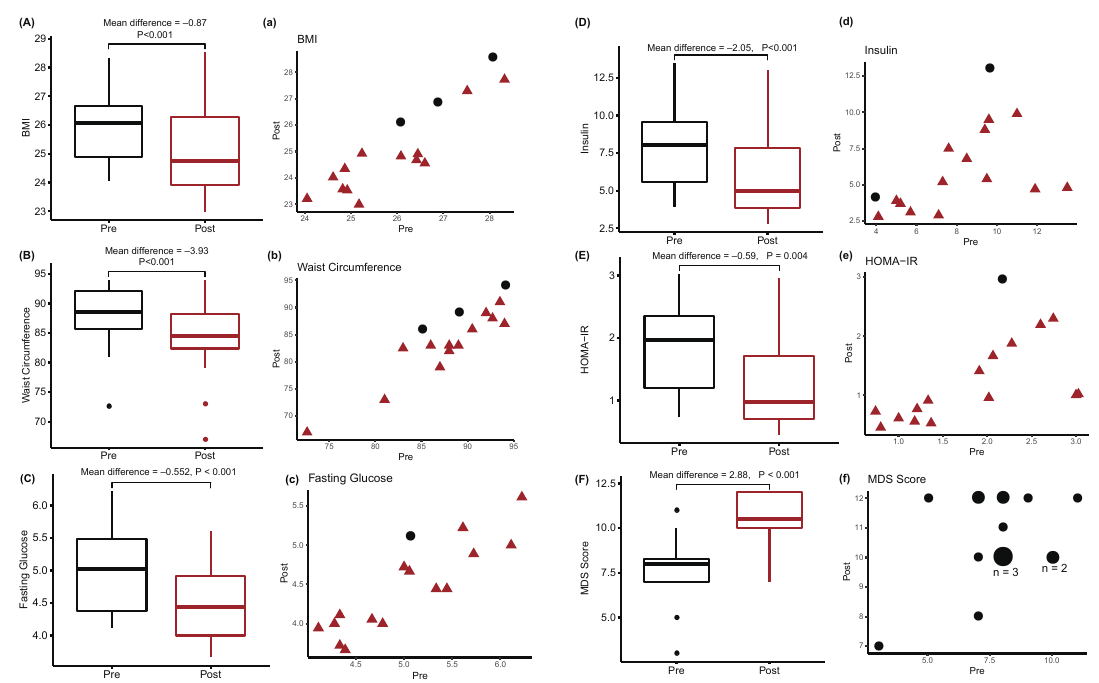
Figure 1. Changes in metabolic indices induced by the MD in overweight breast cancer survivors. The panels annotated by the capital letters ( A – F ) represent box-whisker plots of metabolic indices before andafterintervention. p -valueswerecalculatedbythepairedStudent’s t -testafterKolmogorov–Smirnov test. The panels annotated by the lowercase letters ( a – f ) represent scatter plots of the same data as in ( A – F ). Red triangles indicate values that decreased after the intervention. Black circles indicate values that increased after the